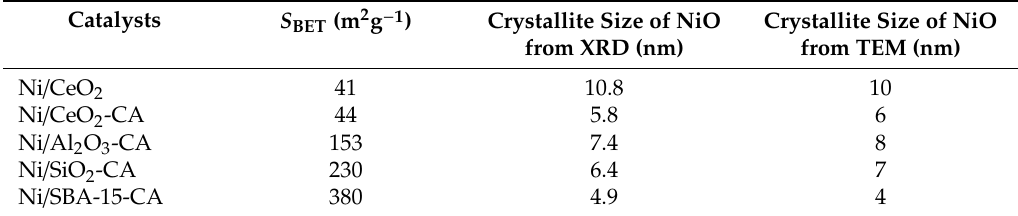
Table 1. Structure parameters of di ff erent